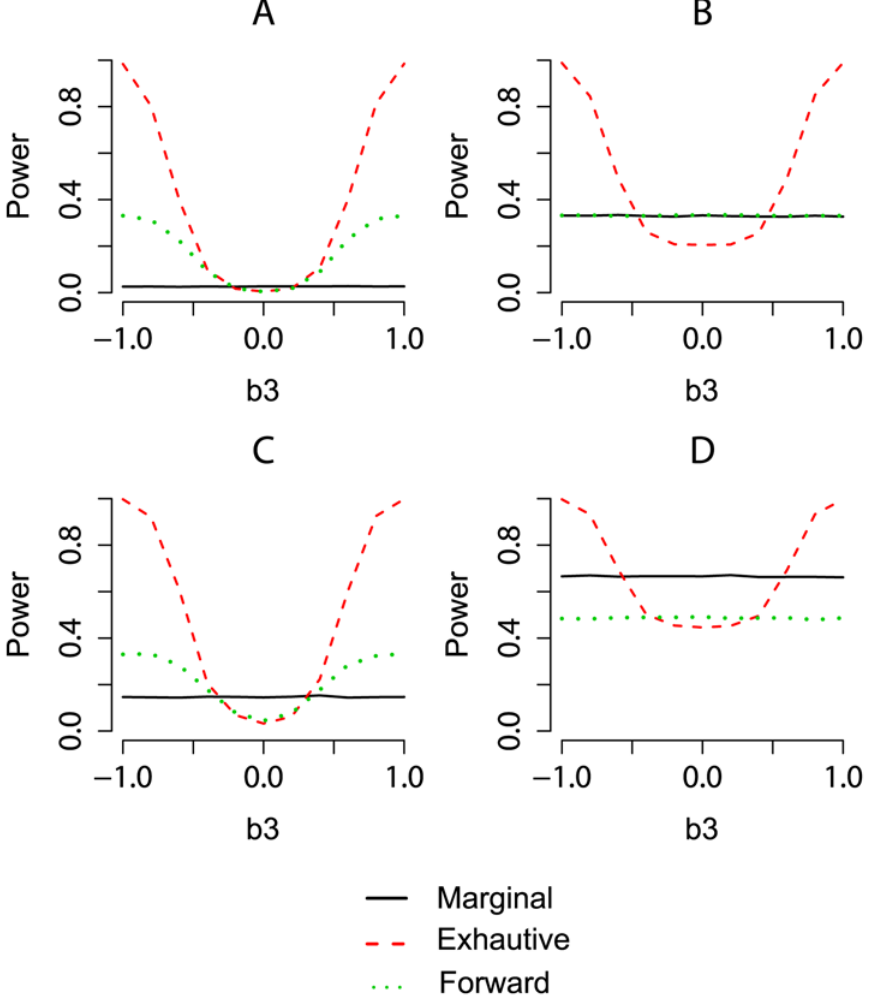
Figure 4. Plots of model selection power with given observed marginal effects. Power comparisons of three model selection procedures over a sequence of epistatic effect b 3 : marginal search by black solid curve, exhaustive search by red dashed curve, and forward search by green dotted curve. We assume the true SNPs to be rs11107116 and rs10906982, which influence adult height with their marginal effects set to be the same as those observed in Weedon et al. 2008. Graphs A with R =1 and C with R =20 indicate the power of finding both SNPs; graphs B with R =1 and D with R =20 indicate the power of finding at least one of the two SNPs.